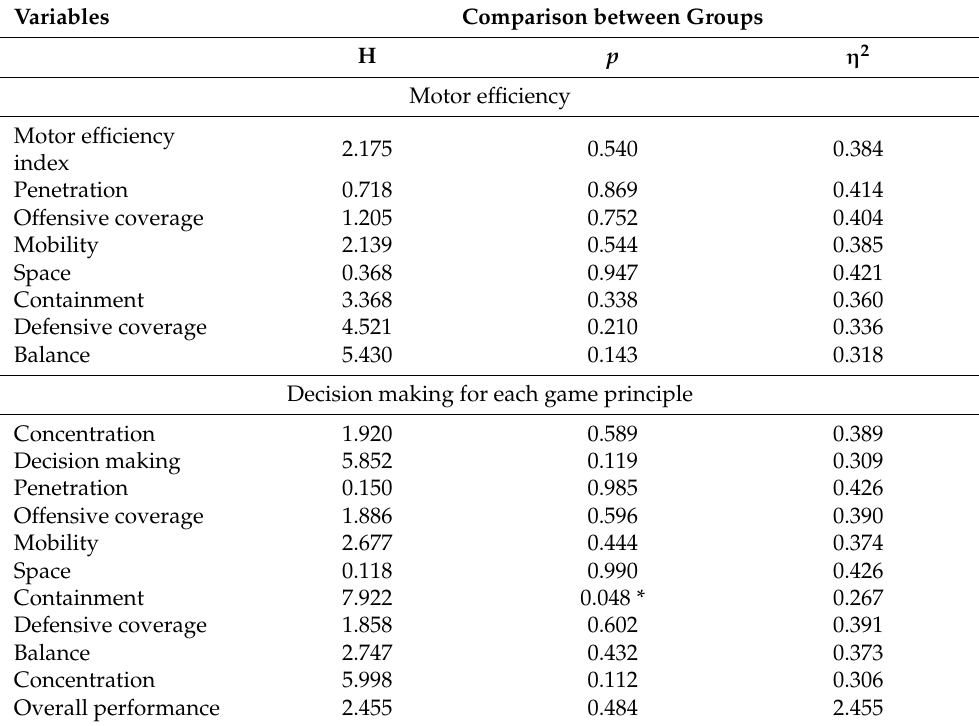
Table 7. Mean comparisons between ranks in motor efficiency and decision making for each game